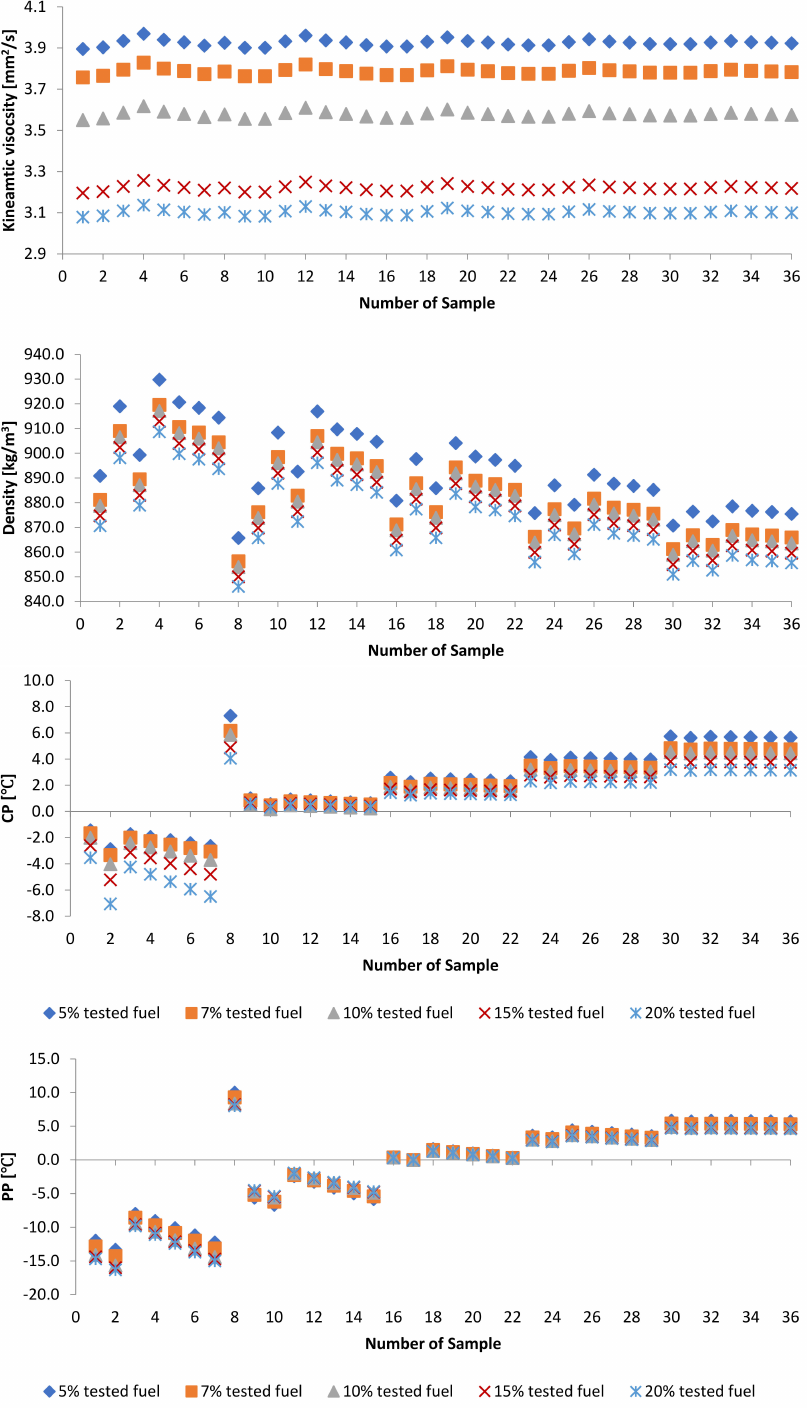
Figure 12. Properties of WFME-PME-KF with various volume